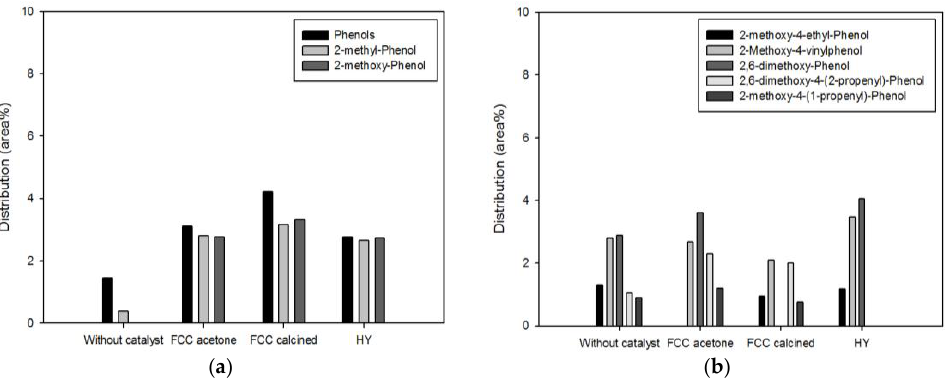
Figure 6. Detailed phenolic species distributions obtained from non-catalytic and catalytic pyrolyses with biomass:catalyst = 1:1: ( a ) small-molecular-mass phenolics; and ( b ) large-molecular-mass phenolics.